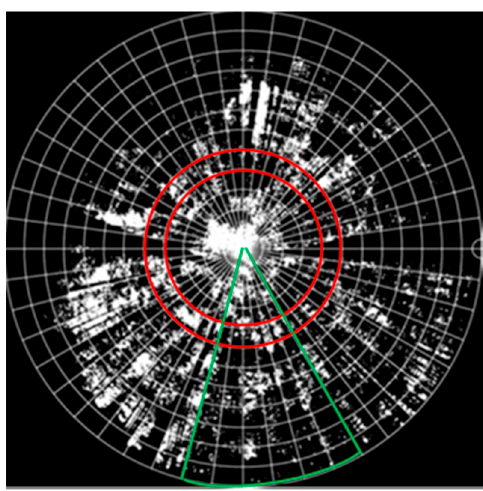
Figure 12. Subregion divisions of the CHP.